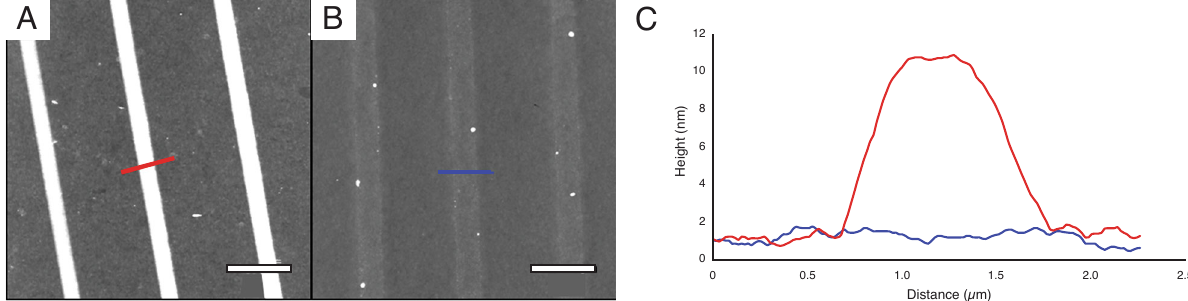
Fig. 2 Atomic force microscopy images of 3D nano-printed line arrays using spatially controlled assembly and polymerization from initiated substrates as well as control substrates, demonstrating the active crosslinking reaction. A 15 µ m × 15 µ m AFM topographic image of an array of the crosslinked polymer lines on a ROMP-active quartz surface. B 15 µ m × 15 µ m AFM topographic image of an array of lines printed with the same protocol as A without the catalyst present on a quartz surface. C Combined cursor pro fi le from the two cursors indicated in A (red) and B (blue). Scale bars = 3 µ 11 nm tall and 1.7 µm wide, and 100 µm long. Under identical conditions and using a clean quartz substrate without catalyst, control experiments were carried out. As shown in Fig. 2B, minimal p(PEGA-co-HEANB) assembly or cross-linking occur- red. Figure 2C compares the AFM trace of the crosslinking system vs. the non-initiated control experiment (no catalyst), clearly showing the much taller line formed by the nano-3D printing system (11 nm) than that in the control (0.6 nm). The robustness of the observations was proven by printing larger features using a “ micropipette ” with 4 µm pore. An array of four lines, 300 µm long, were produced, each was 60 nm tall with the base width ranging from 10 to 25 µm (Supplementary Figure 5). In contrast,